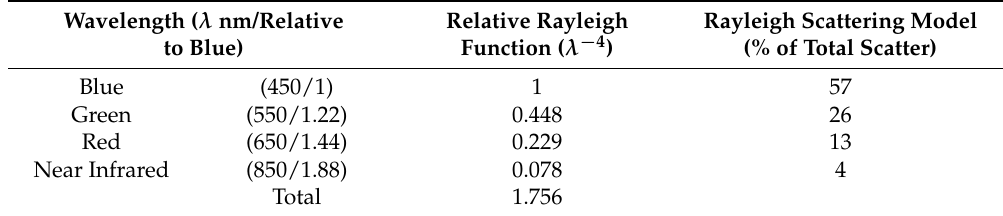
Table 1. Relative Rayleigh scattering model ( λ − 4 ) applied to visible and NIR wavelengths. Percentage of total scatter is used to create a diffuse skylight vector. A worked example is the Green wavelength where 1.22 − 4 = 0.448 resulting in 0.448/1.756 = 0.26 (or 26%). Wavelength ( λ nm/Relative to